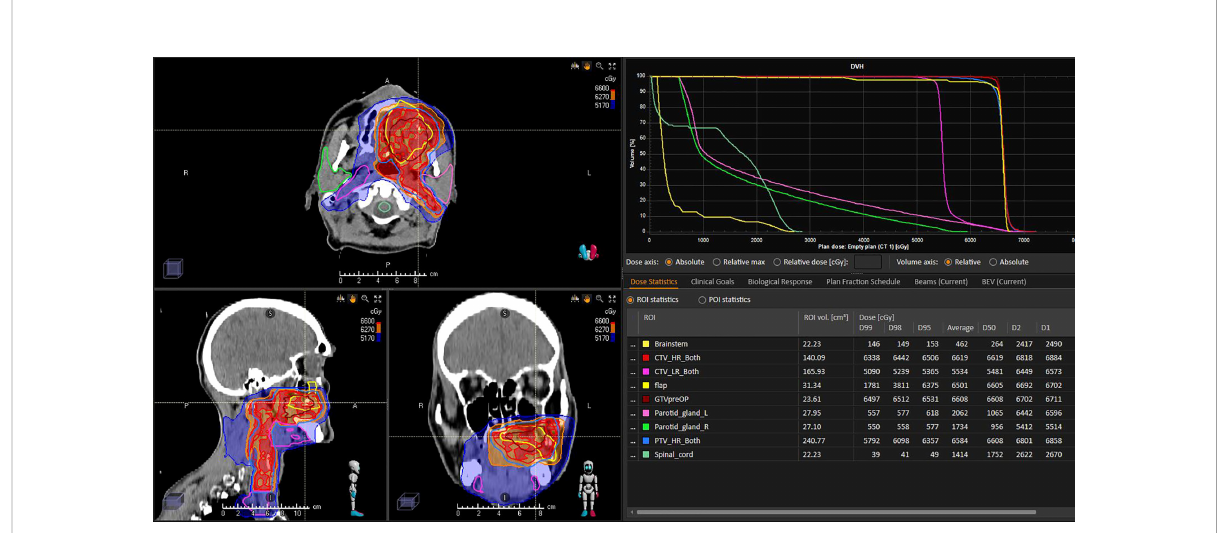
FIGURE 7 Postoperative radiotherapy planning of a left palatine squamous cell carcinoma following reconstructive surgery with a soft-tissue forearm fl ap. The fl ap (yellow line) was not delineated for RT planning and has been delineated a posteriori independently of referring radiation oncologist and blind to CTV delineation. Analysis of radiation dose distribution suggests that the fl ap was considered as a target volume and received the highest dose prescription level (66 Gy, within red 62.7Gy